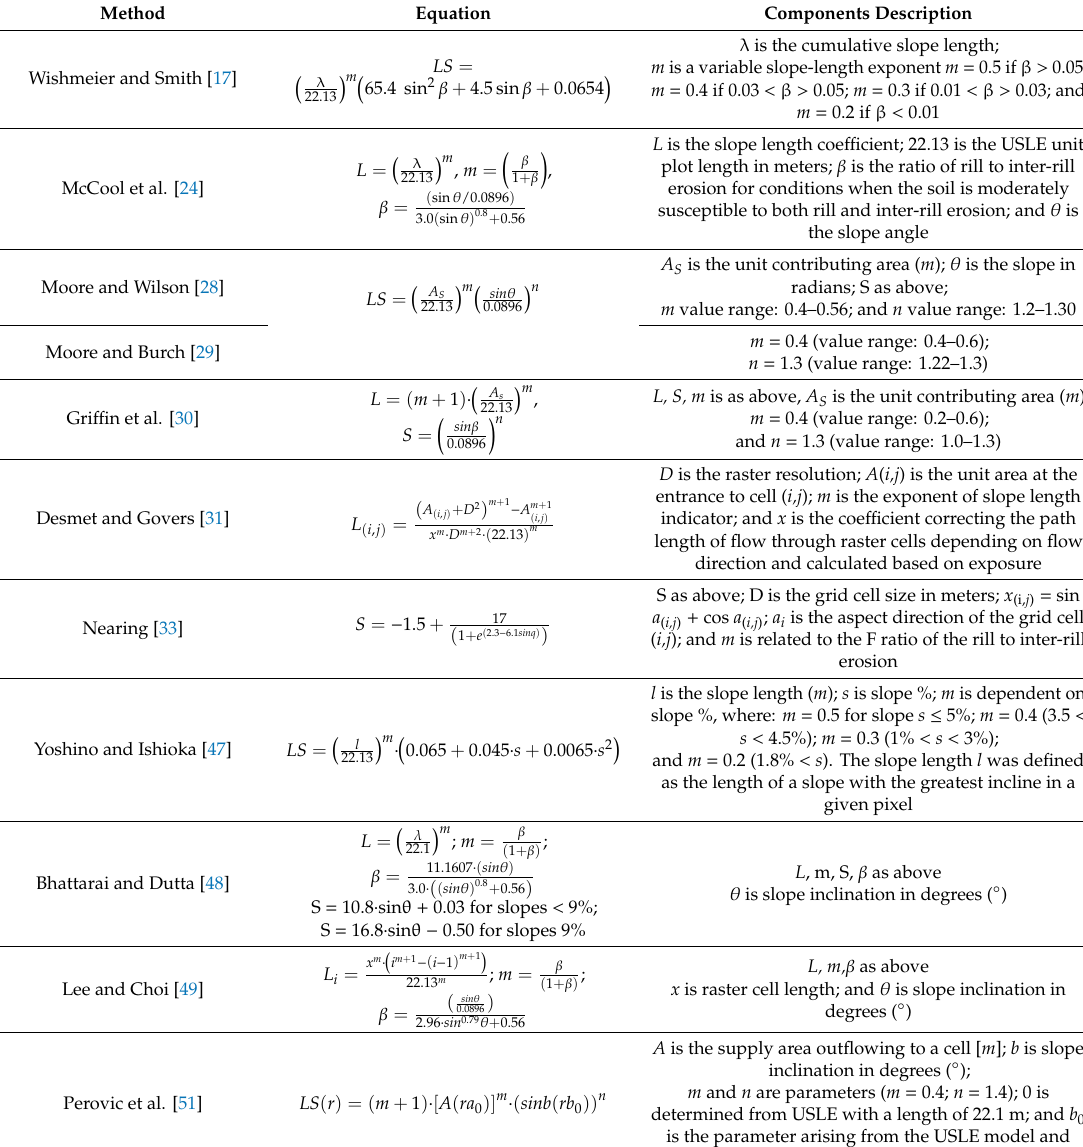
Table 1. Methods of calculating the LS parameter of USLE